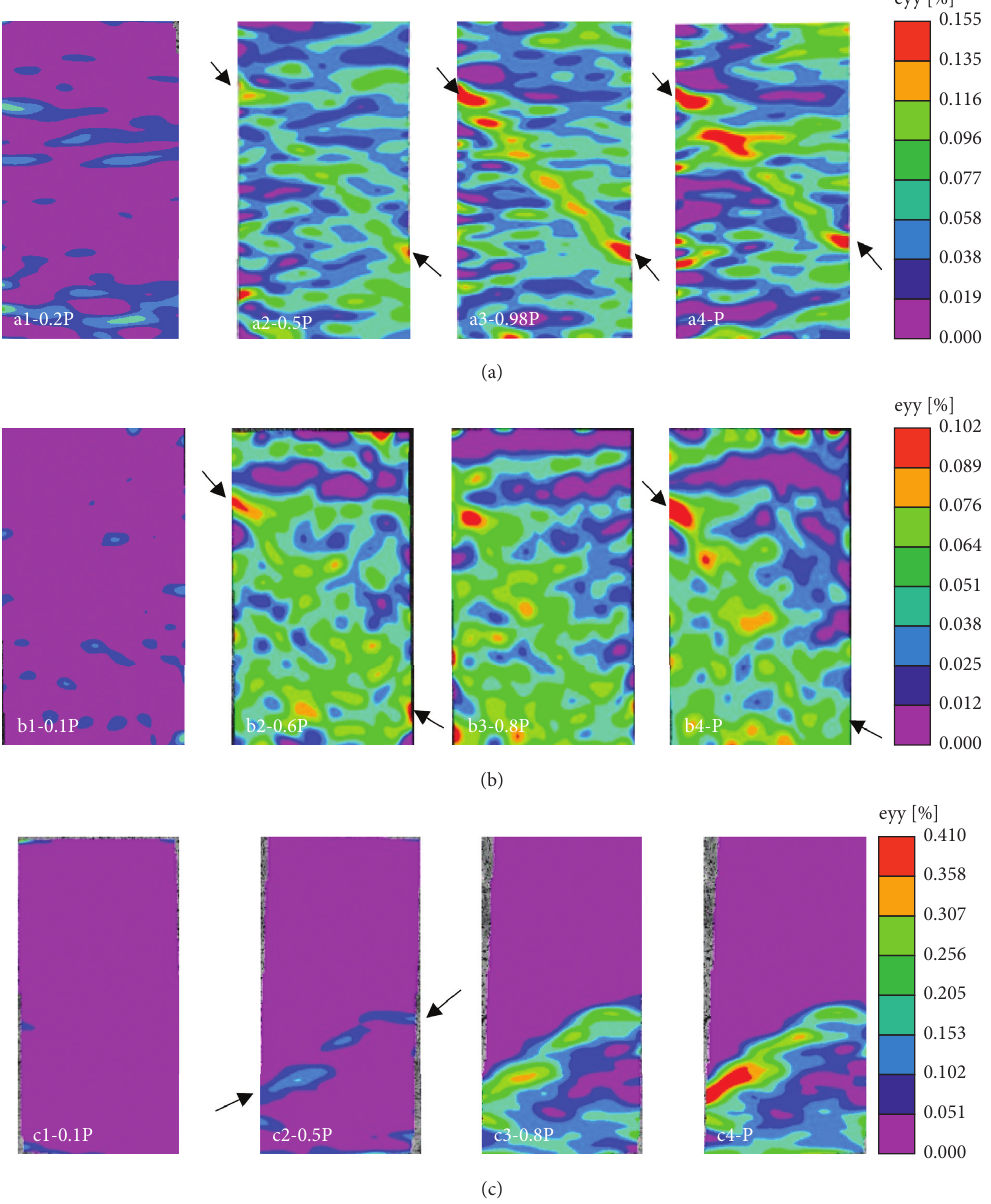
Figure 8: Vertical strain field for specimen with various surface treatment types at different loading stages: (a) C50-C50-WB-45 ° (primary surface), (b) C50-C50-MG-45 ° (primary surface), and (c) C50-C50-AC-45 ° (primary